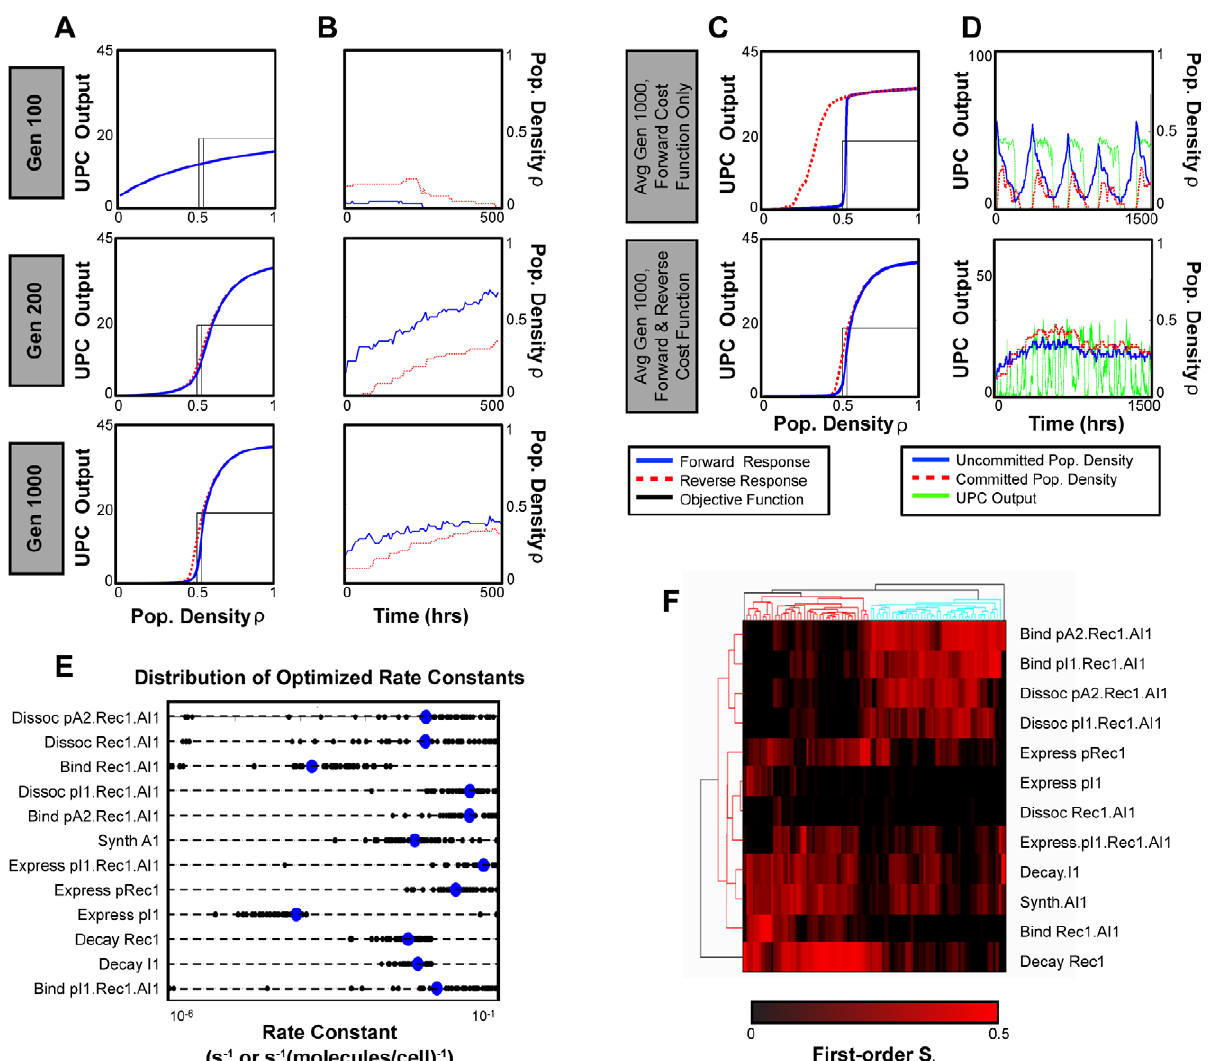
Figure 6. Parametric optimization of the UPC module. (A) GA optimization progress for three representative generations, using an ODE model of the UPC module. The GA objective function is a three-component step-function, with zero UPC activity below a defined threshold, an ignored transition region, and high activity above the transition region. (B) Gillespie simulations of System 3, corresponding to optimization progress in A . (C) Average UPC module transfer curves when the reverse response is either excluded or included in the subnetwork GA optimization. (D) Full system behavior corresponding by row to the module optimization results in C . (E) Distribution of rate constants for the optimized parameter vectors determined by 75 independent GA runs of 1000 generations each, using both forward and reverse response objective functions. (F) Clustered sensitivity analysis of the UPC Module. Each column corresponds to a ‘‘parameter sensitivity signature’’ for each of the 75 local parameter neighborhoods that we sampled; rows correspond to the analyzed parameters of the UPC module. First-order sensitivity values shown in the heat map range from 0.0 (black) to 0.5 (red).